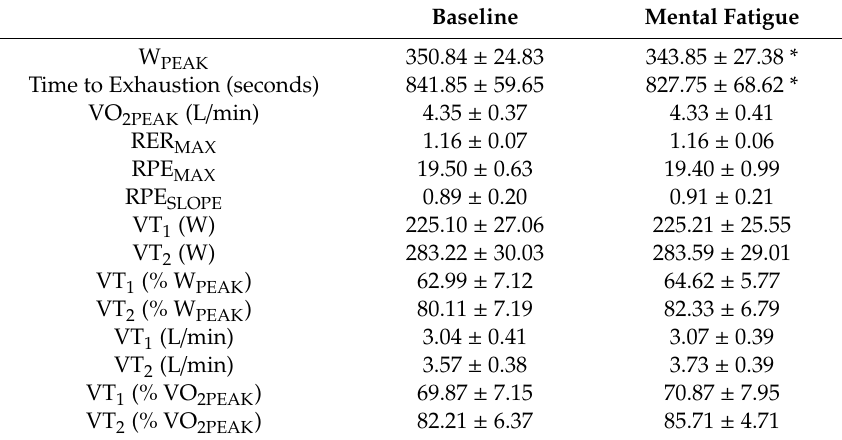
Table 1. Proof-of-principle study of the mental fatigue e ff ects on maximal incremental test